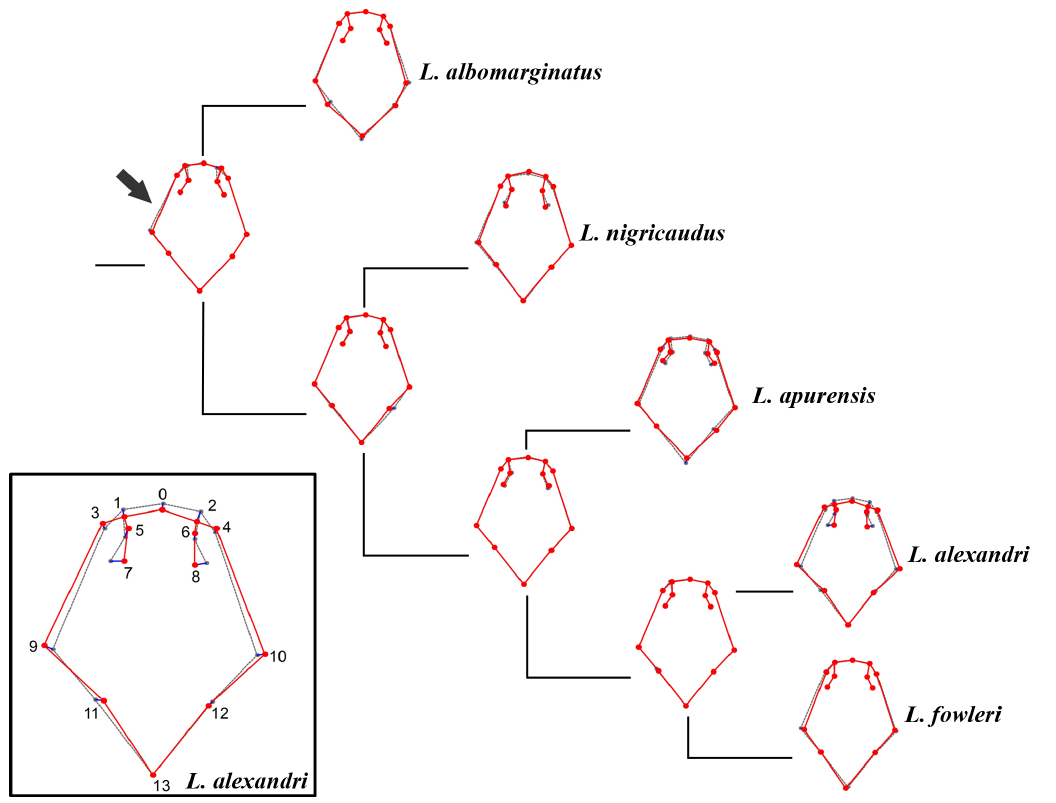
FIGURE 11 | Inferred phylogeny and landmark mapping (numbers) on the head of Lophiosilurus species. The arrow indicates the ancestral configuration. Enlarged image of Lophiosilurus alexandri in the box (grey lines = ancestral shape; red lines = reconstructed shape, blue lines = landmark position changing to the corresponding node in the